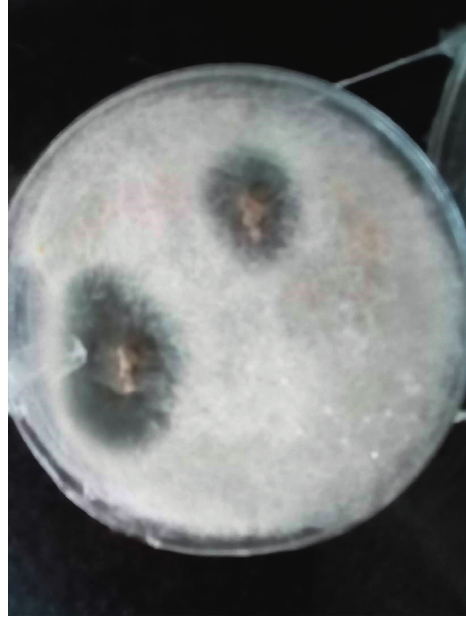
Figure 7: Colonies were identified as Aspergillus fumigatus and Rhizopus arrhizus